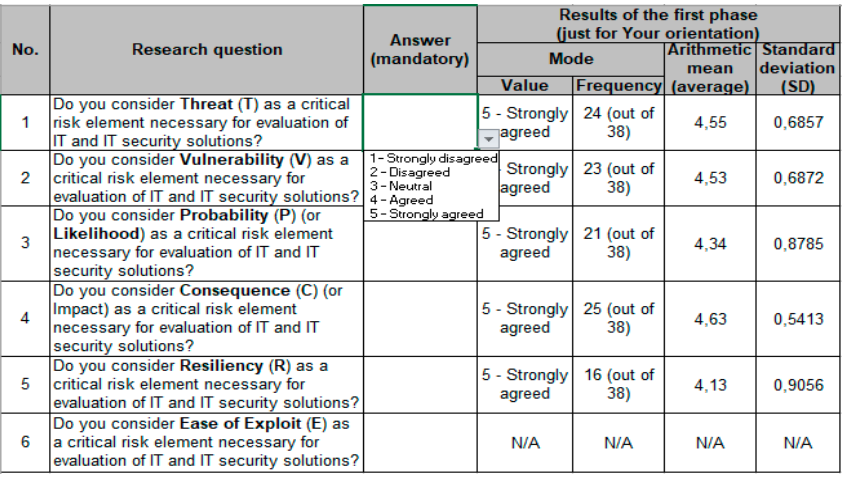
Figure A3. Research questionnaire for the second Delphi round, which presented statistics from the first Delphi round and also included an exploitability (E) element for rating as a potential additional criterion for the new multicriteria model.